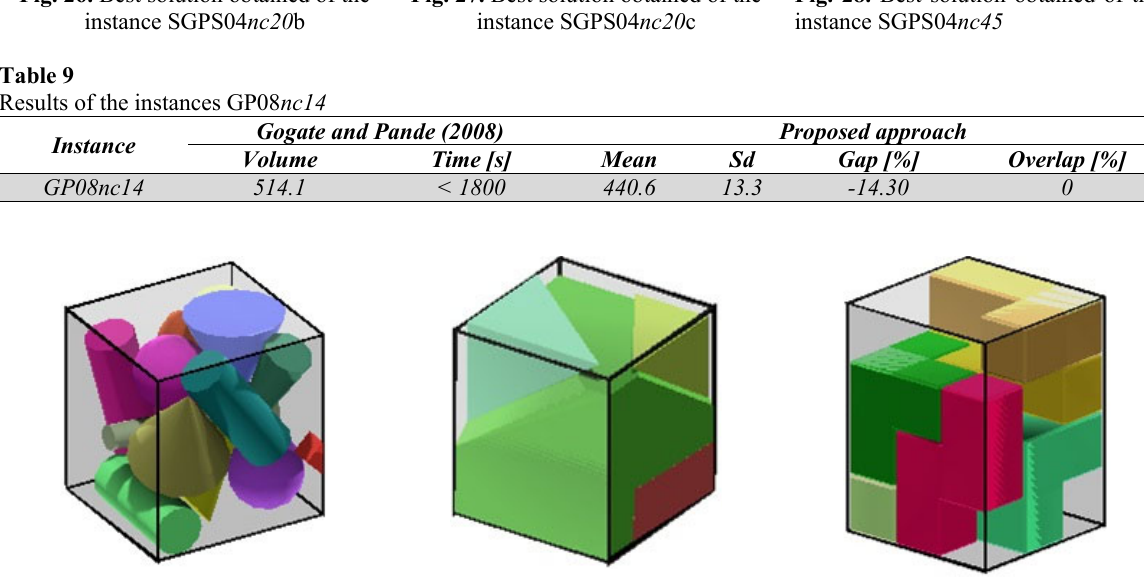
Fig. 29. Best solution obtained of the Fig. 30. Best solution obtained of the Fig. 31. Best solution obtained of